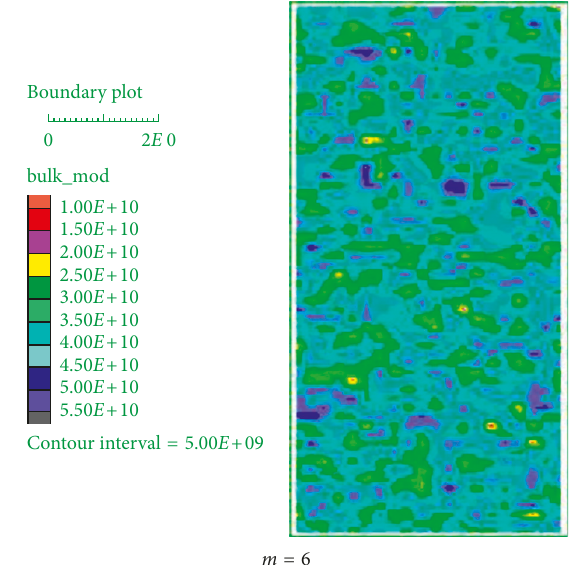
Figure 11: The local stress-strain curves of the elements with different stiffness.